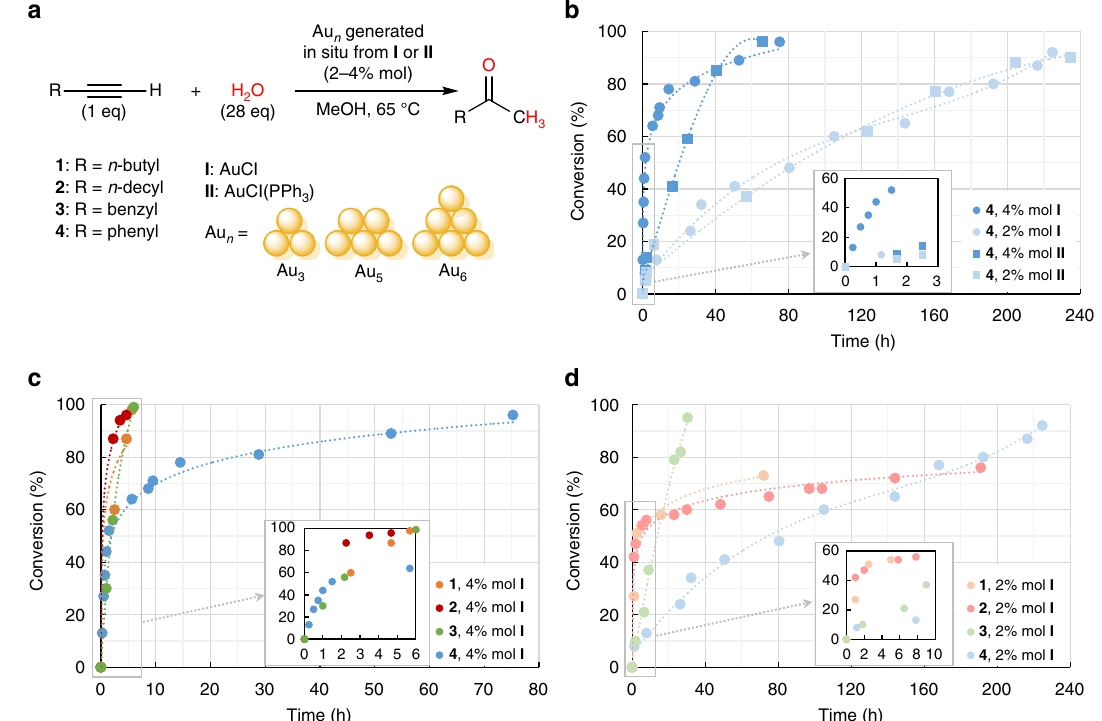
Fig. 1 Hydration of alkynes catalyzed by Au(0) subnanoclusters. a Markovnikov hydration of alkynes in re fl uxing methanol catalyzed by Au(0) subnanoclusters of different sizes. b Kinetics of phenylacetylene ( 4 ) hydration catalyzed by Au(0) subnanoclusters generated from 4 and 2% mol of AuCl and AuCl(PPh) 3 , showing that 4% mol AuCl is the most ef fi cient precatalyst. c , d Kinetics of 1-hexyne ( 1 ) and 1-dodecyne ( 2 ) and benzylacetylene ( 3 ) hydration catalyzed by Au(0) subnanoclusters generated from 4 and 2% mol of AuCl, compared to those of phenylacetylene ( 4 ). A much higher